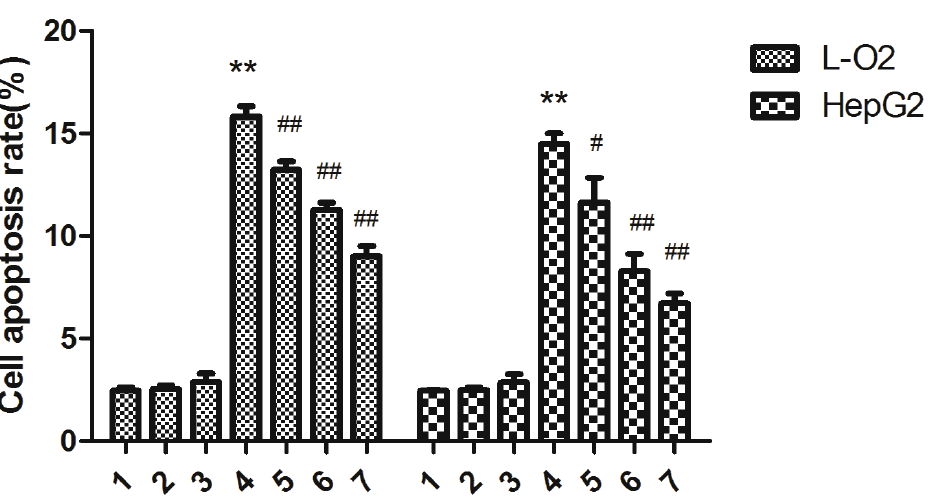
Figure 4: Influence of dose on apoptosis. The apoptosis of L-O2 and HepG2 cells treated with Shugan Xiaozhi Fang at different doses for 24 h was detected using flow cytometry. 1: Normal group; 2: blank control group; 3: Fenofibrate group 4: model group; 5: low dose group; 6: medium dose group; 7: high dose group. *p<0.05, **p<0.01vs the normal group. #p<0.05，##p<0.01 vs the model